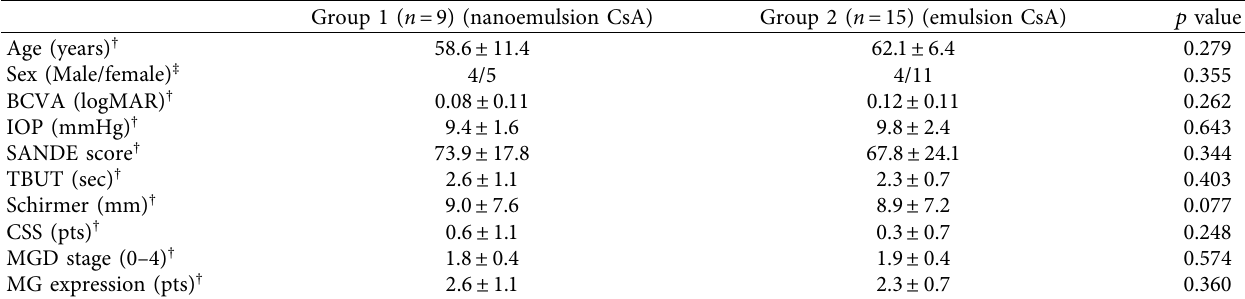
Figure 1: Schematic illustration of enrolled patients. Table 1: Baseline characteristics in patients.